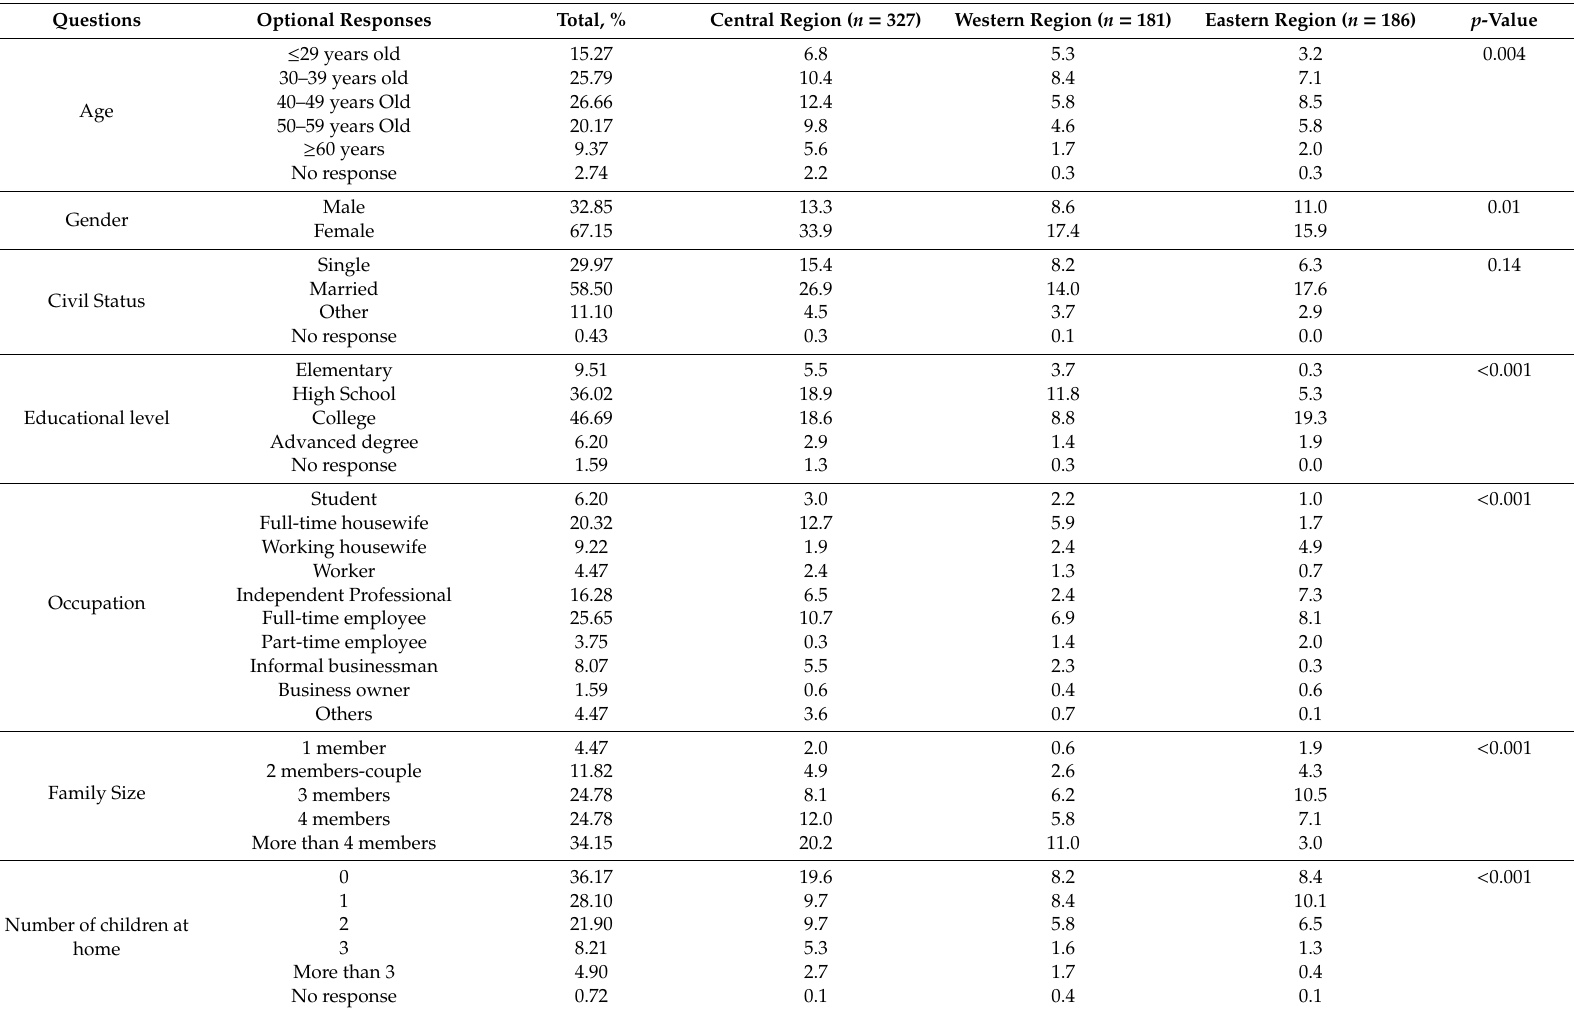
Table 1. Demographic characteristics for the whole sample and by